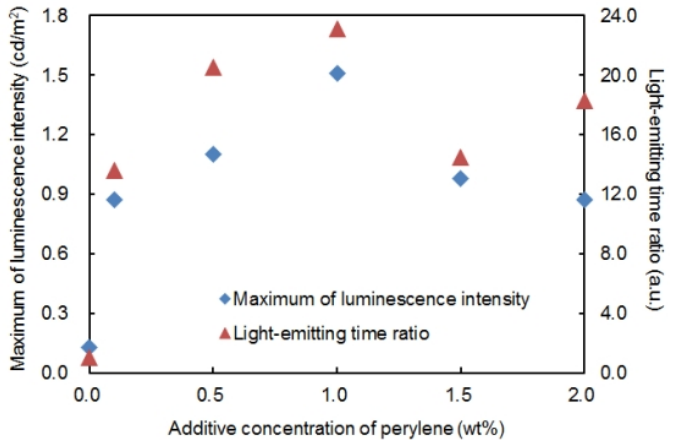
Figure 3. Maximum of luminescence intensity (square blue plots) and light-emitting time ratio (triangle red plots) of the poly(3-octylthiophene-2,5-diyl) electrochemiluminescence device with different additive concentrations of perylene from 0.0 to 2.0 wt %. Applied voltage is AC voltage of 5.0 V at 417